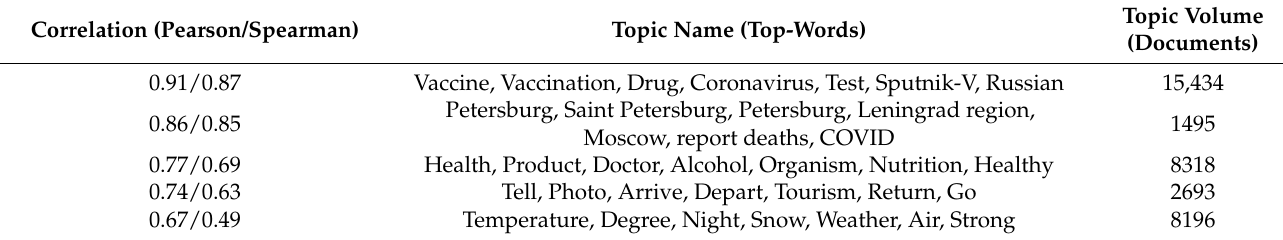
Table 4. Correlation between the number of new deaths from COVID-19 and topics from the initial topic model. Correlation (Pearson/Spearman) Topic Name